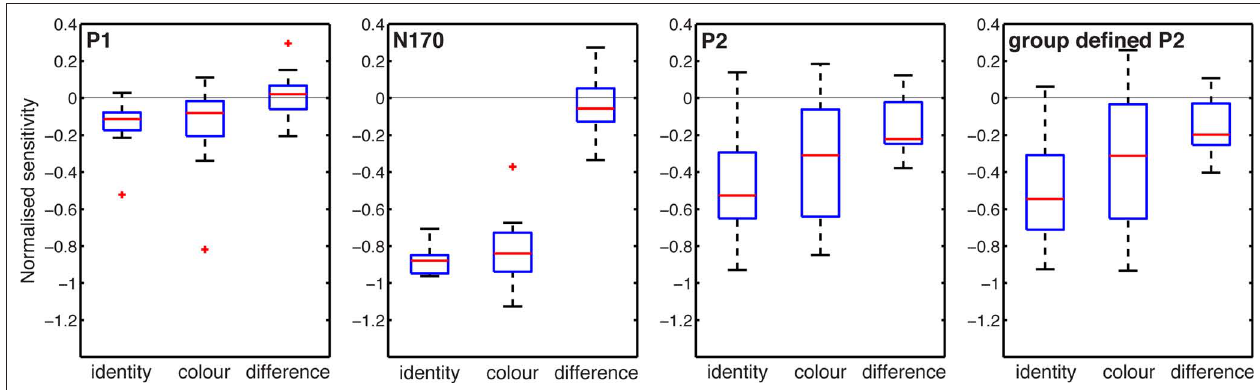
FiGuRE 4 | Task effects around peak time-windows. Noise sensitivity in the two tasks was normalized by dividing by the maximum absolute noise sensitivity in the identity task. The three first ERP peaks were measured at these latencies across subjects: P1 (median = 96, min = 82, max = 119), N170 (median =